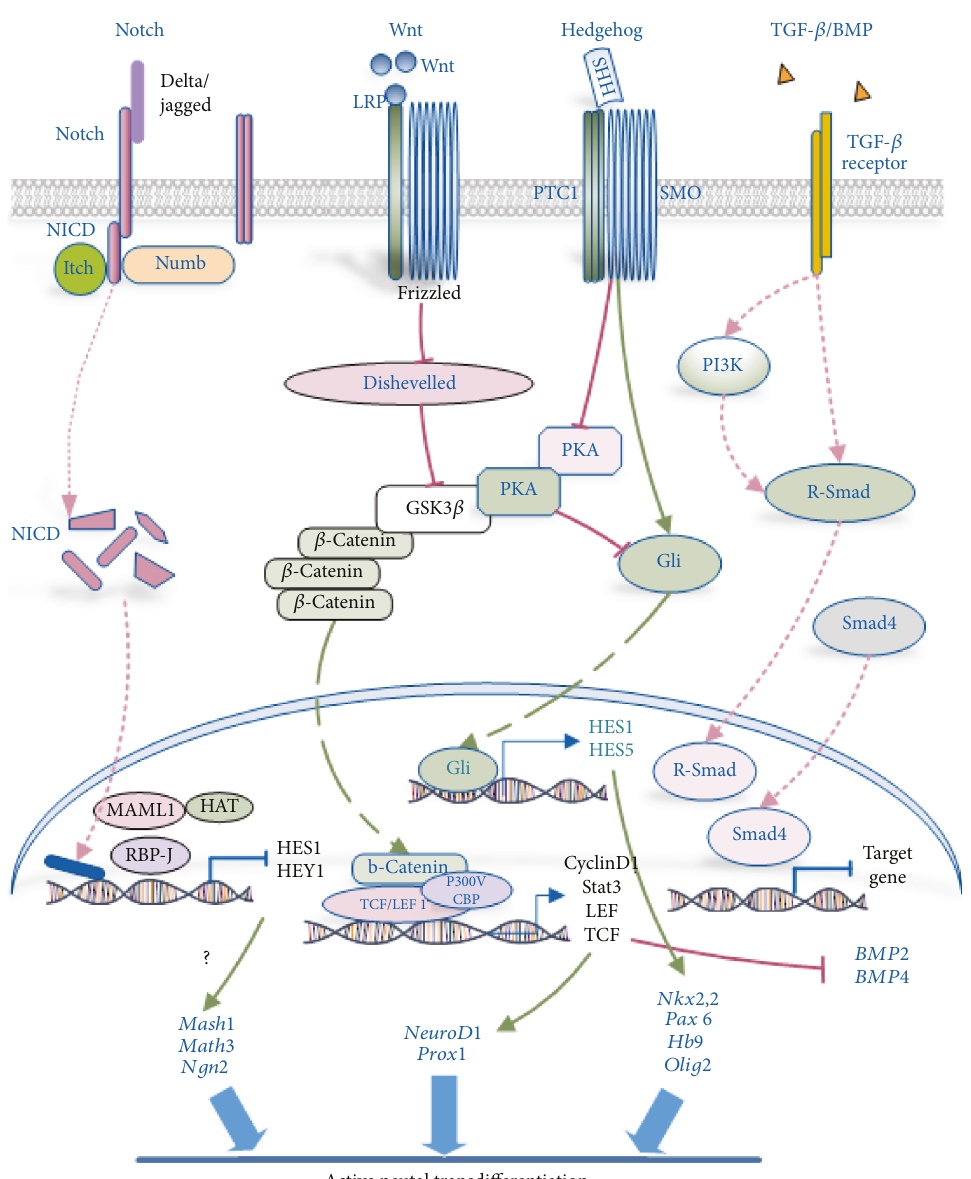
Figure 2: Overview of several important pathways involved in regulating the transdi ff erentiation of NSCs and neural cells. The Wnt, Notch, hedgehog, and TGF- β signaling pathways have been implicated in the transdi ff erentiation of neural cells. Activation or inhibition of these signaling pathways as well as their cross-talk may initiate cell conversion, maintain the self-renewal of stem cells, and drive their transdi ff erentiation. Akt: protein kinase B; Dvl: dishevelled; GFs: growth factors; GliR: Gli repressors; GSK3 β : glycogen synthase 3 beta; LEF1: lymphoid-enhancing factor-1; NICD1: Notch intracellular domain-1; PI3K: phosphatidylinositol-3-kinase; PKA: protein kinase A; Ptch: patched; R-smad: receptor-regulated Smads; Shh: sonic hedgehog protein; SMO: smoothened; TCF: T cell factor transcription factor; Wnt: